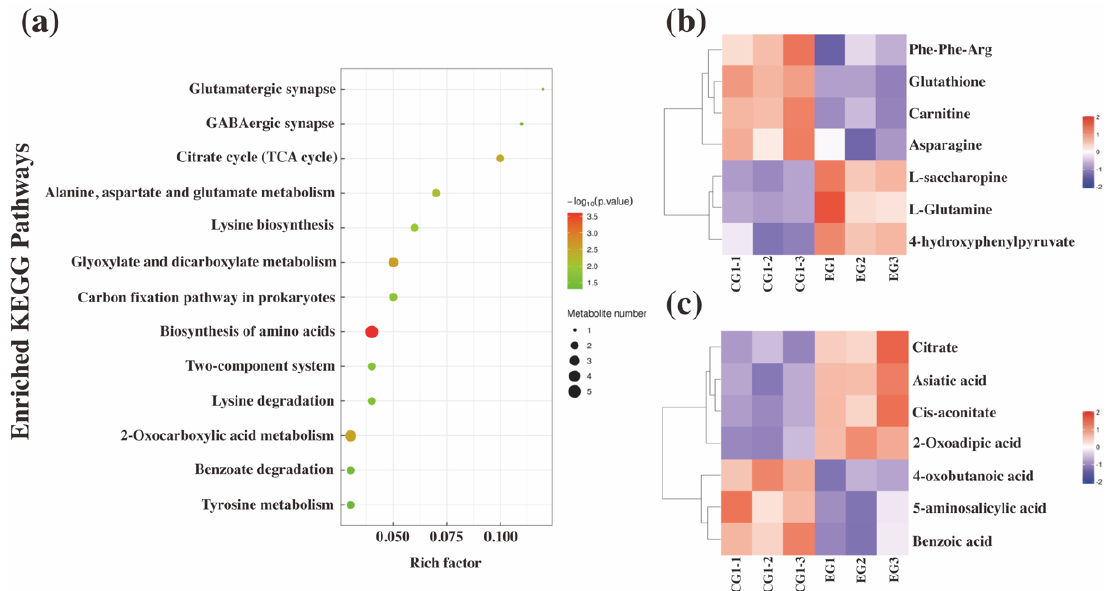
Figure 3. The bubble map of KEGG enrichment pathway for differential metabolites ( a ). Cluster analysis of significantly differential metabolite in P. pastoris after sodium citrate treatment. ( b ) Amino acid metabolism − related; ( c ) organic acid metabolism − related.